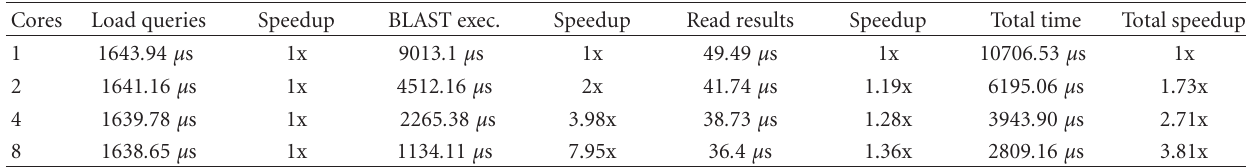
Table 4: Performance of one to eight BLAST cores running in a PowerPC 440 Redsharc system. 100MHz SSN, BSN, and BLAST Kernel Clocks.